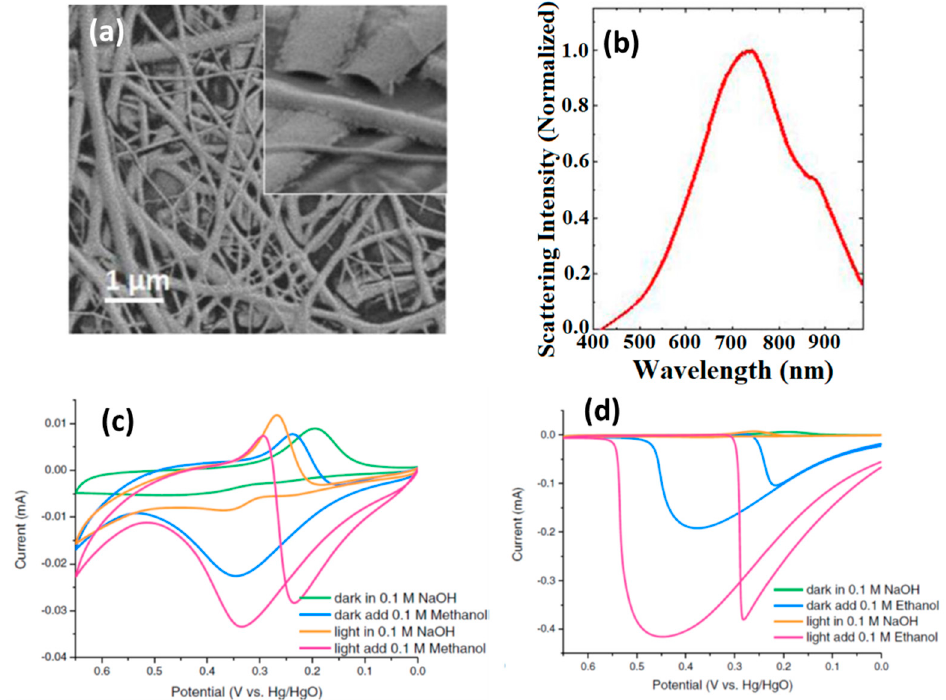
Figure 3. ( a ) SEM image of an Au nanofiber plasmonic electrode; ( b ) UV/Vis spectrum of Au nanofiber electrode; ( c ) cyclic voltammograms of Au nanofiber electrode under light or in the dark recorded in NaOH (0.1 M) in the presence or absence of methanol (0.1 M); ( d ) cyclic voltammograms of Au nanofiber electrode under light or in the dark recorded in NaOH (0.1 M) in the presence or absence of ethanol (0.1 M) (reprinted with the permission of Ref.[11]).